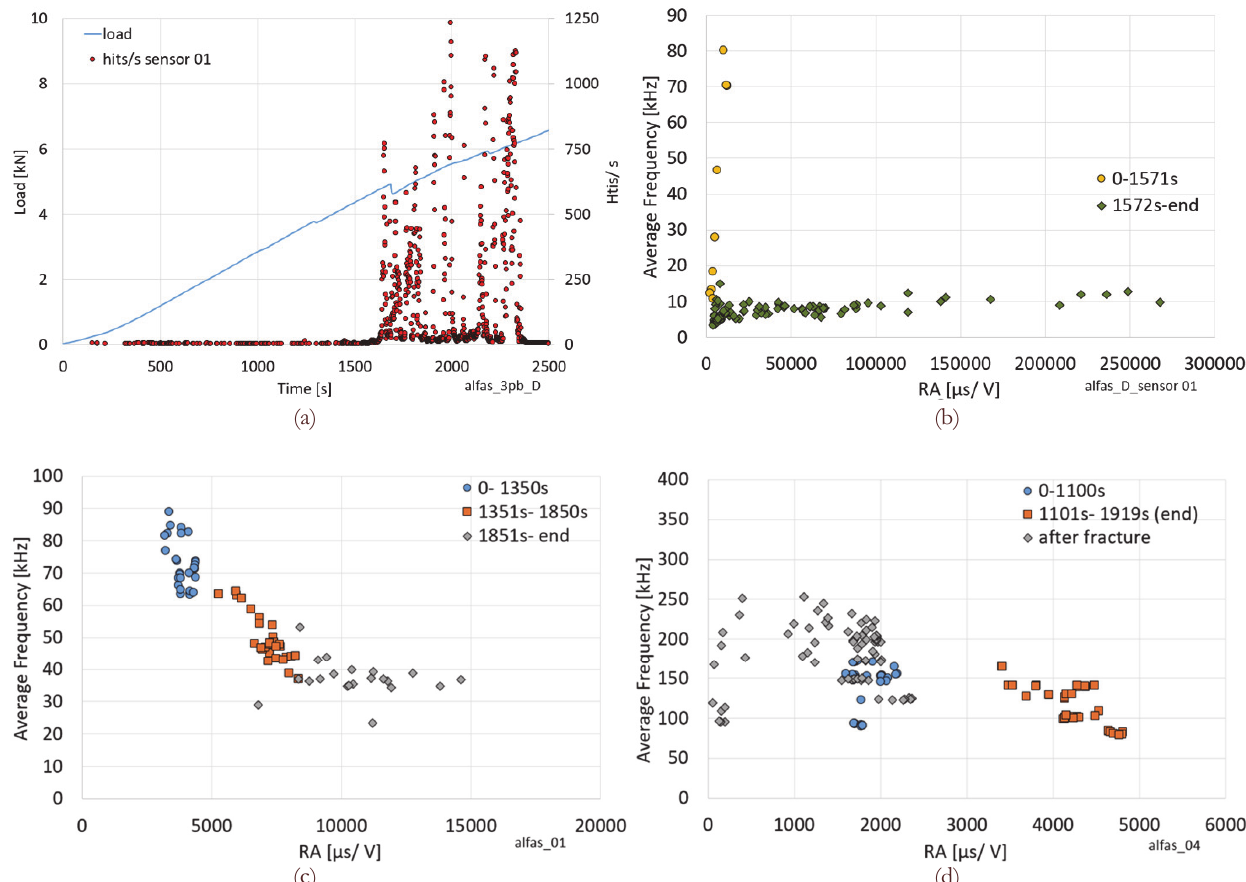
Figure 9: (a) The time variation of the hits/s and the load applied; (b) Average frequency versus the RA parameter (c) and (d) Average frequency versus the RA parameter for two additional characteristic experiments with Alfas stone